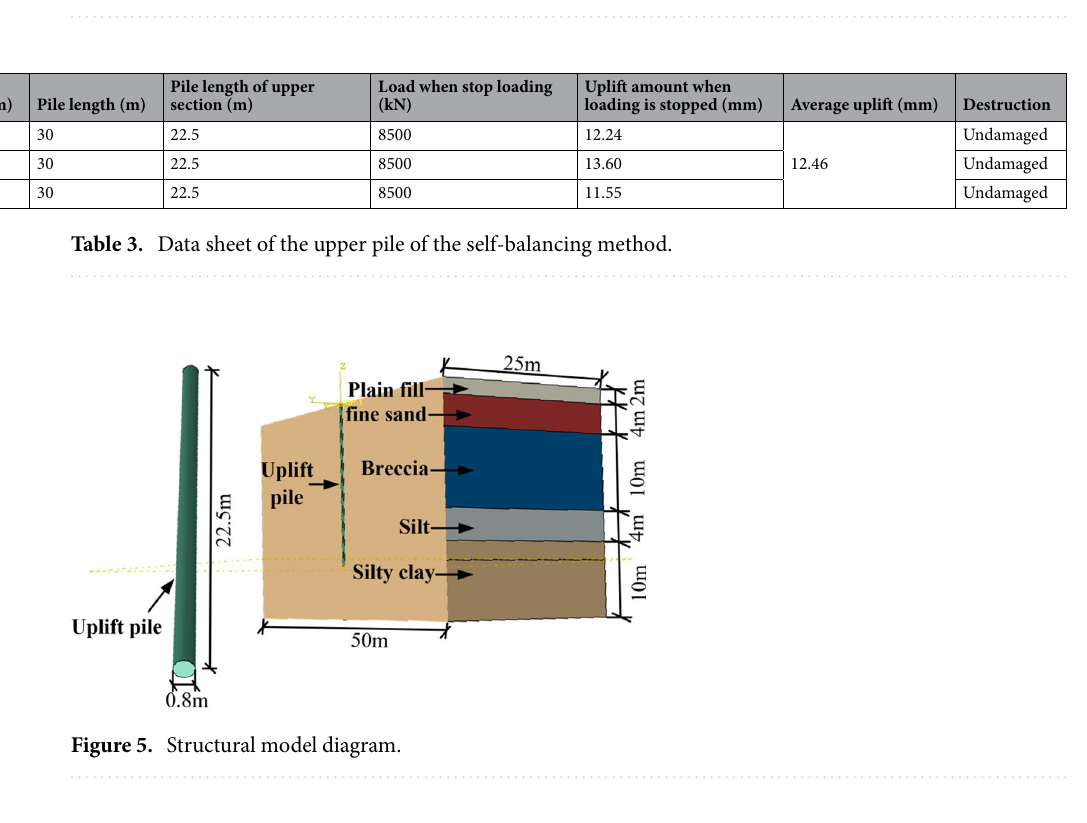
Table 2. Data sheet of the anchor pile method.